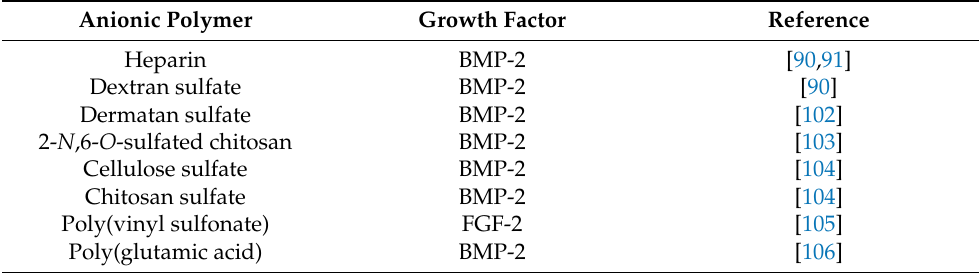
Table 1. Anionic polymers to enhance the activity of growth